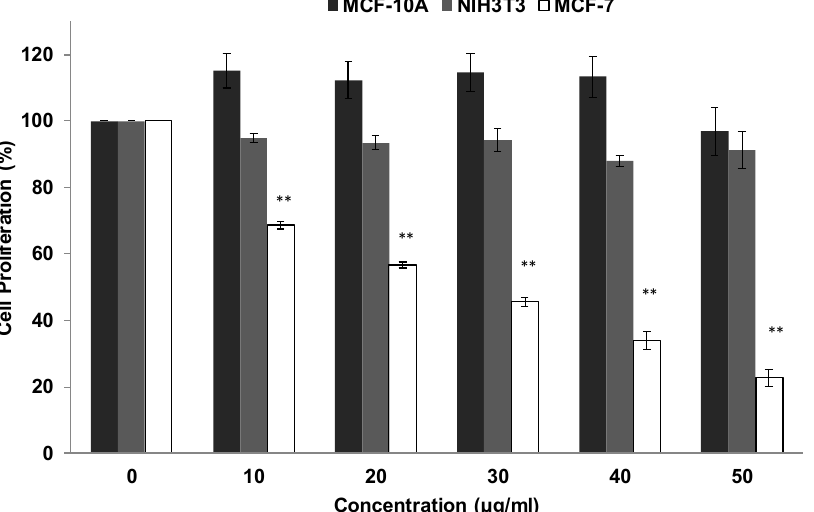
Figure 1. Antiproliferative effect of RTEAL on breast cancer cell line. MCF-7, MCF-10A and NIH3T3 cells were treated with RTEAL at the concentrations as indicated for 72 h. The assay was performed using MTT reagent. Data were presented as mean ± SEM of the three independent experiments with triplicate for each treatment. Asterisks indicate a significant difference (** p < 0.01) for each concentration was compared to the control cells.